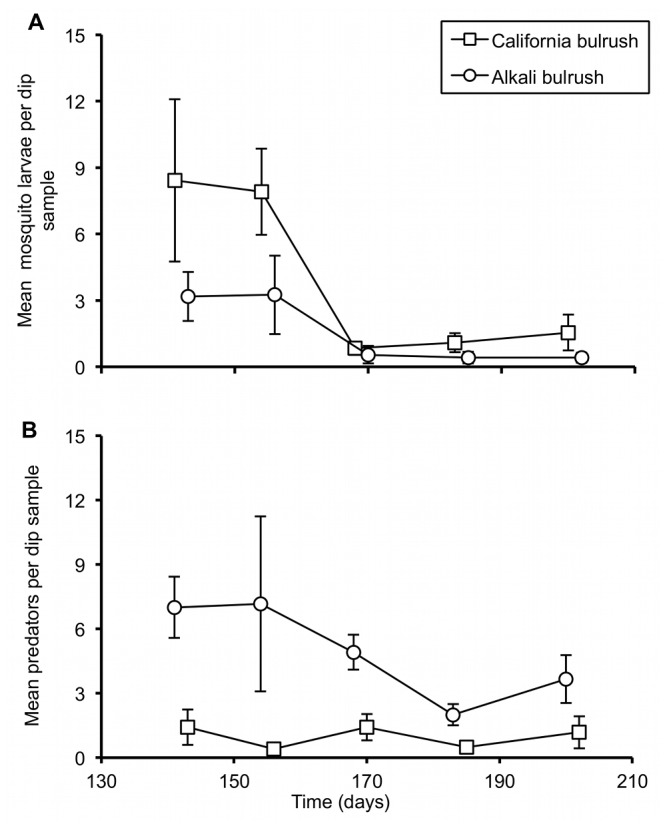
Mosquito and invertebrate predator abundance.Repeated-measures analysis of variance showed that mean numbers of mosquitoes, Panel A and invertebrate predators (zygopteran predators), Panel B varied significantly (p< 0.05) between mesocosms planted with alkali bulrush and California bulrush. Alkali bulrush significantly harbored more predators and fewer mosquitoes as compared to the California bulrush. The x-axis represented time after the onset of the experiment. Error bars represent the standard error of the mean based on four replicate mesocosms per plant species.